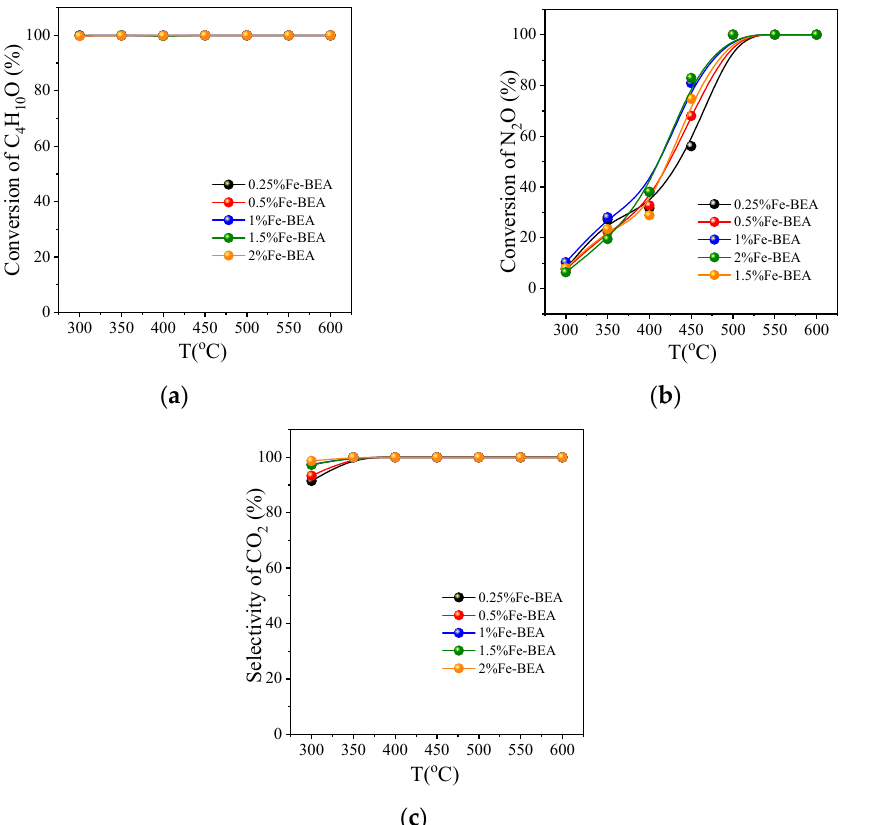
Figure 8. Catalytic oxidation of C 4 H 10 O on Fe-BEA with different concentrations: ( a ) the conversion of C 4 H 10 O; ( b ) the conversion of N 2 O; ( c ) the selectivity of CO 2 ; reaction conditions: GHSV = 8000 h − 1 , C 4 H 10 O:N 2 O:O 2 :He = 0.2:7:5:87.8.